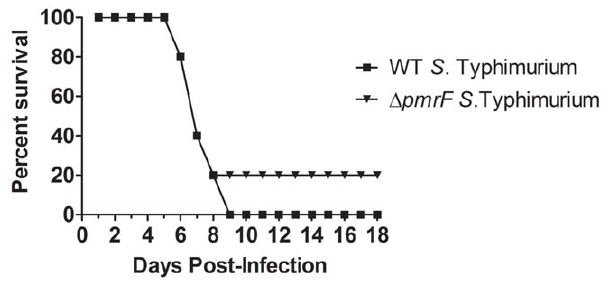
Figure 7. Survival of IL-13 KO BALB/c mice infected with WT or D pmrFS. Typhimurium. IL-13 KO mice on a BALB/c background were infected by oral route with 10 4 CFU of WT or D pmrF S. Typhimurium (n=5 mice), and were monitored for morbidity and mortality.